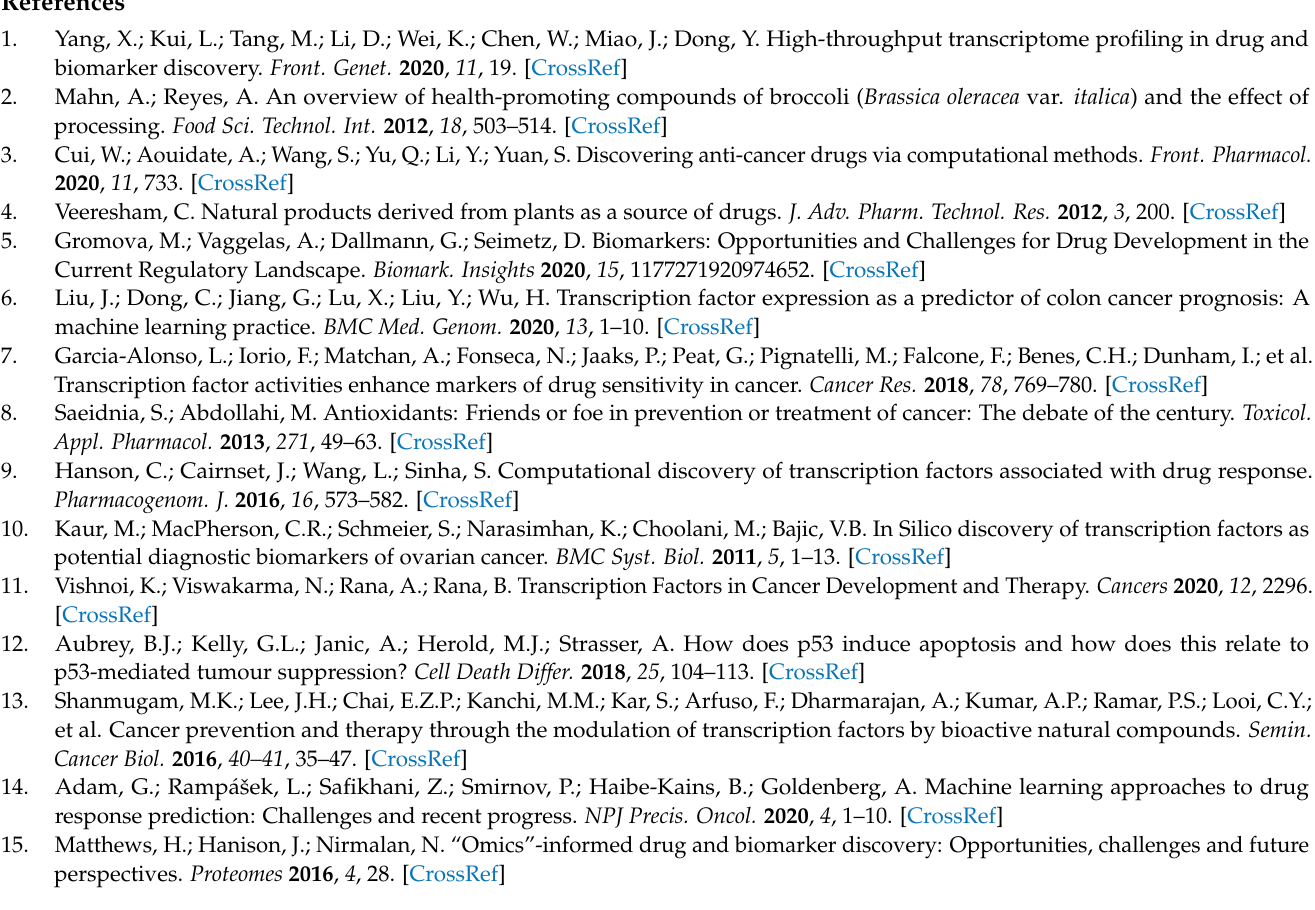
Table S2: RPKM indexes of 58175 genes in 13 different levels, Table S3: The results of meta-analysis, Table S4: List of classified genes, Table S5: Go enrichment details for TFs for molecular function, biological process, and cellular component terms, Supplementary File S1: Results of different machine learning models in predicting transcription factor signatures, Figure S1: RPKM meta-analysis of thirteen datasets for overall expression of AIP in treated and control groups, Figure S2: RPKM meta-analysis of thirteen datasets for overall expression of VGLL4 in treated and control groups, Figures S3 and S4: RPKM meta-analysis of thirteen datasets for overall expression of ID1 in treated and control